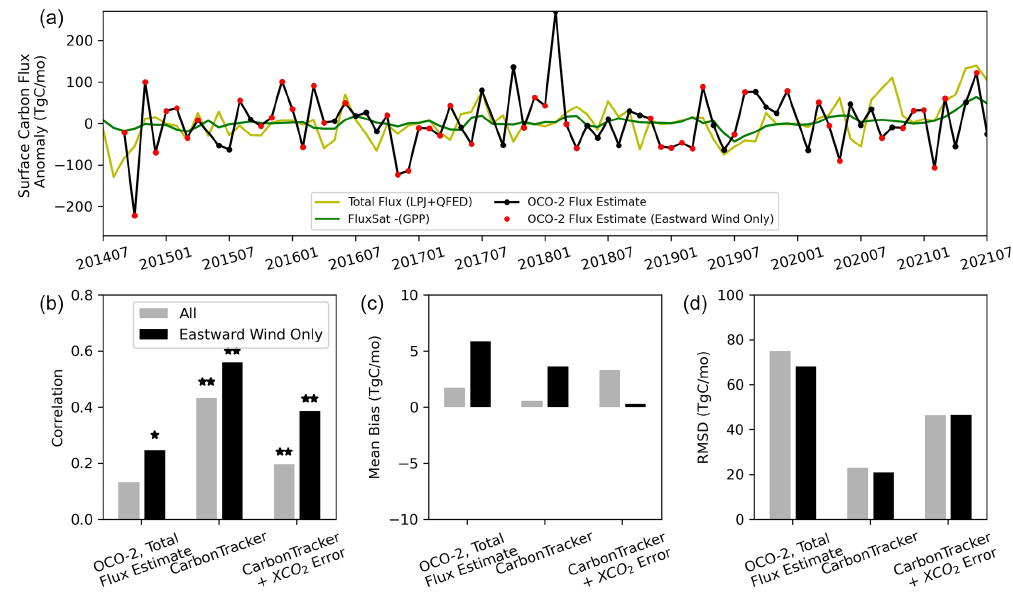
Figure 7. (a) Spatially averaged OCO-2 XCO 2 flux anomaly estimates compared to total CO 2 flux estimate anomalies (LPJ model and QFED biomass burning) and FluxSat gross primary production anomalies. Positive anomalies of all metrics are fluxes away from the surface (note that GPP’s sign was changed). Comparison statistics between OCO-2 flux anomaly estimates and LPJ NBP anomalies over 2014 to 2021 with (b) correlation ( ∗∗ p value < 0.05; ∗ p value < 0.1), (c) mean bias, and (d) root mean square difference (RMSD). CarbonTracker comparisons are shown for reference as repeated from Fig. 5 but for 2000 to 2018. “CarbonTracker + XCO 2 Error” includes simulated error added to CarbonTracker XCO 2 anomaly outputs on the order of 0.2ppm. The statistics are computed for all data pairs as well as only those considering “Eastward Wind Only” months when the incoming wind direction from the Pacific Ocean was between − 60 and 60 ◦ angles from eastward reference